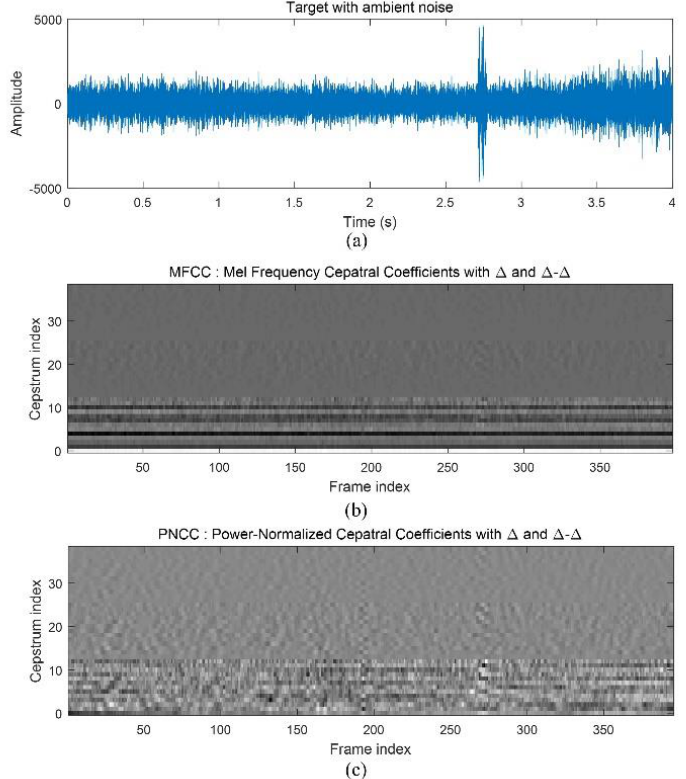
Figure 6. Feature extraction results for target: ( a ) time signal of target with ambient noise; ( b ) MFCC feature extraction result of target; ( c ) PNCC feature extraction result of target.